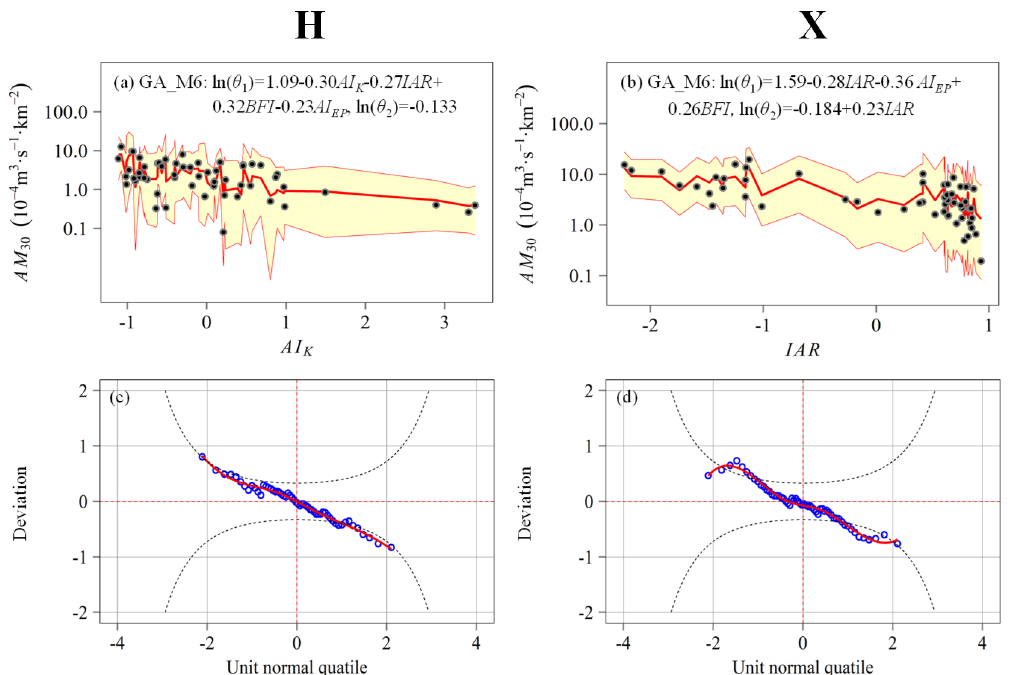
Figure 10. Performance assessments of GA_M6 for AM 30 in Huaxian (H) on the left panel and Xianyang (X) on the right panel. (a) and (b) are the centile curves plots of GA_M6 (red lines represent the centile curves estimated by GA_M6; the 50th centile curves are indicated by thick red; the yellow-filled areas are between the 5th and 95th centile curves; the filled black points indicate the observed series); (c) and (d) are the worm plots of GA_M6 for the goodness-of-fit test; a reasonable model fit should have the data points fall within the 95% confidence intervals (between the two red dashed